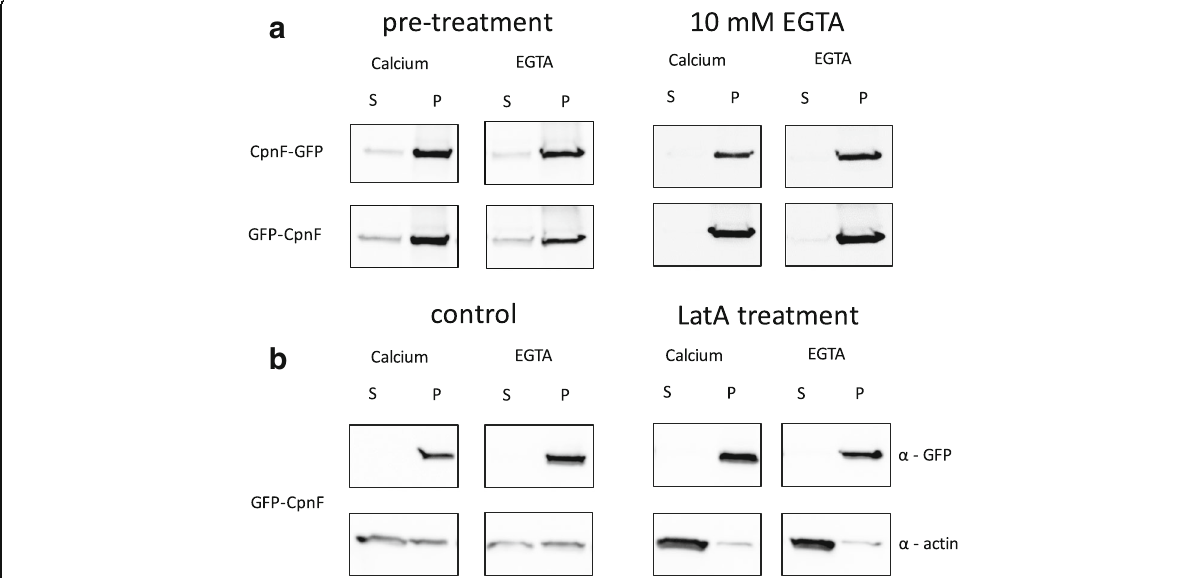
Fig. 6 Pre-treatment, higher concentration of EGTA, and actin depolymerization does not change CpnF binding to membranes. a Cells expressing GFP-CpnF and CpnF-GFP were either disrupted in the presence of EGTA and calcium (pre-treatment) or disrupted and then treated with EGTA (10 mM) and calcium (2 mM). All membranes were pelleted by ultracentrifugation. The supernatant samples (S) and pelleted membranes samples (P) were analyzed by Western blot with an antibody to GFP. b Cells expressing GFP-CpnF were treated with Latrunculin A (LatA) or DMSO (control) for 30 min prior to disruption. All membranes were pelleted by ultracentrifugation. The supernatant samples (S) and pelleted membranes samples (P) were analyzed by Western blot with an antibody to GFP ( α -GFP) and an antibody to actin ( α -actin)